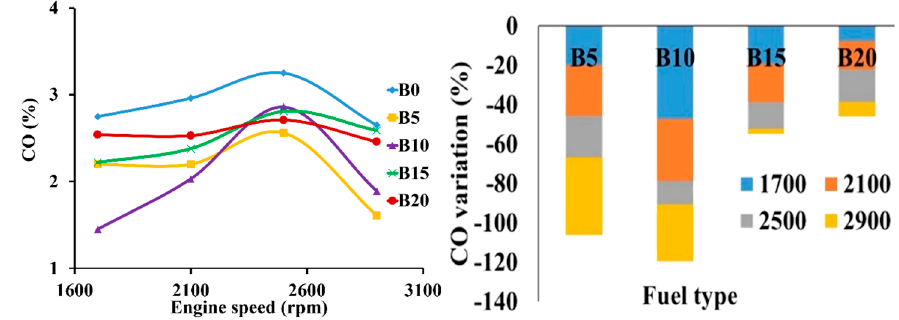
Figure 11. Variation of CO (%) for different engine speeds and diesel biodiesel blends at full load.